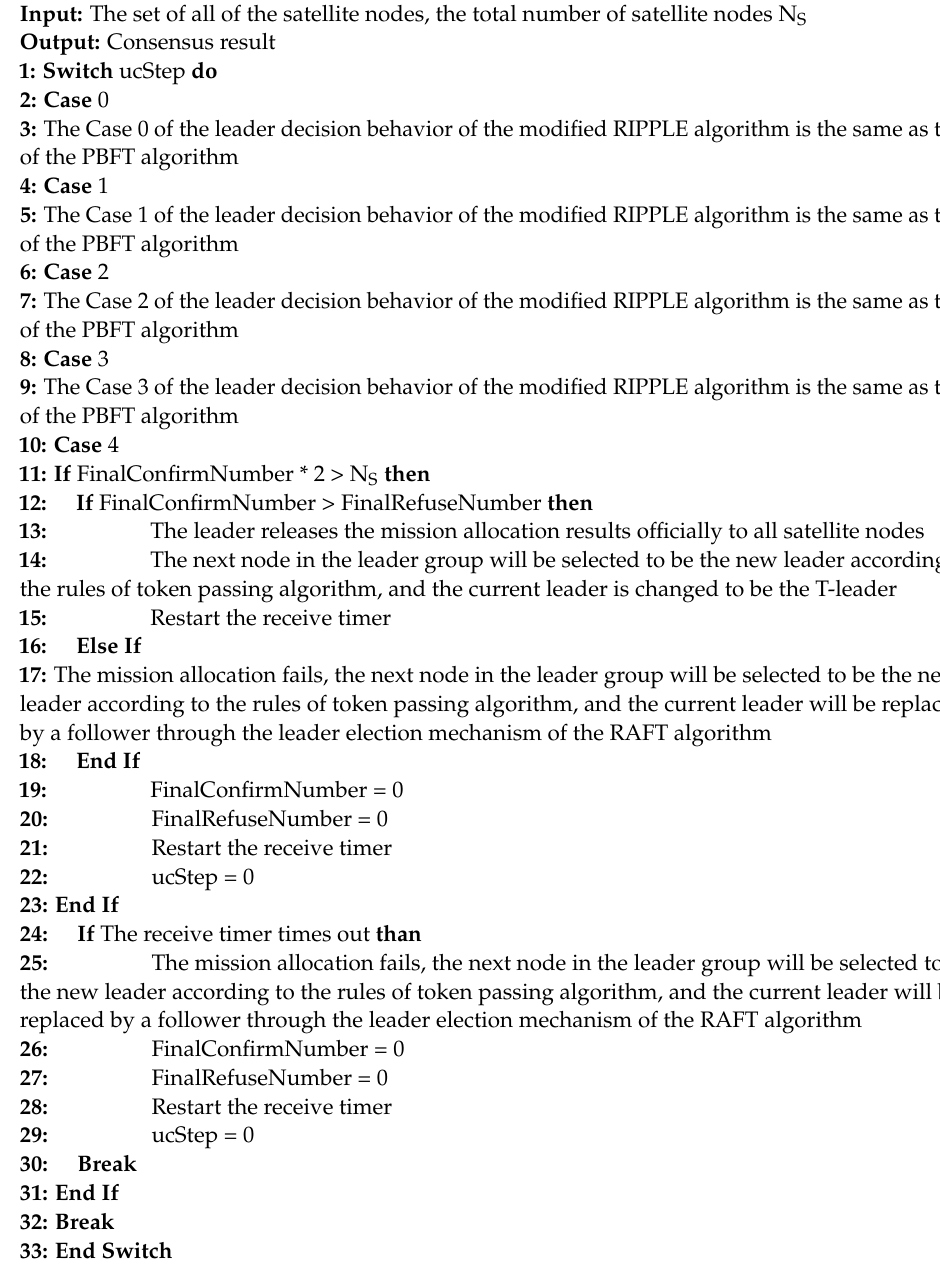
Algorithm 8. The leader decision behavior of the modified RIPPLE